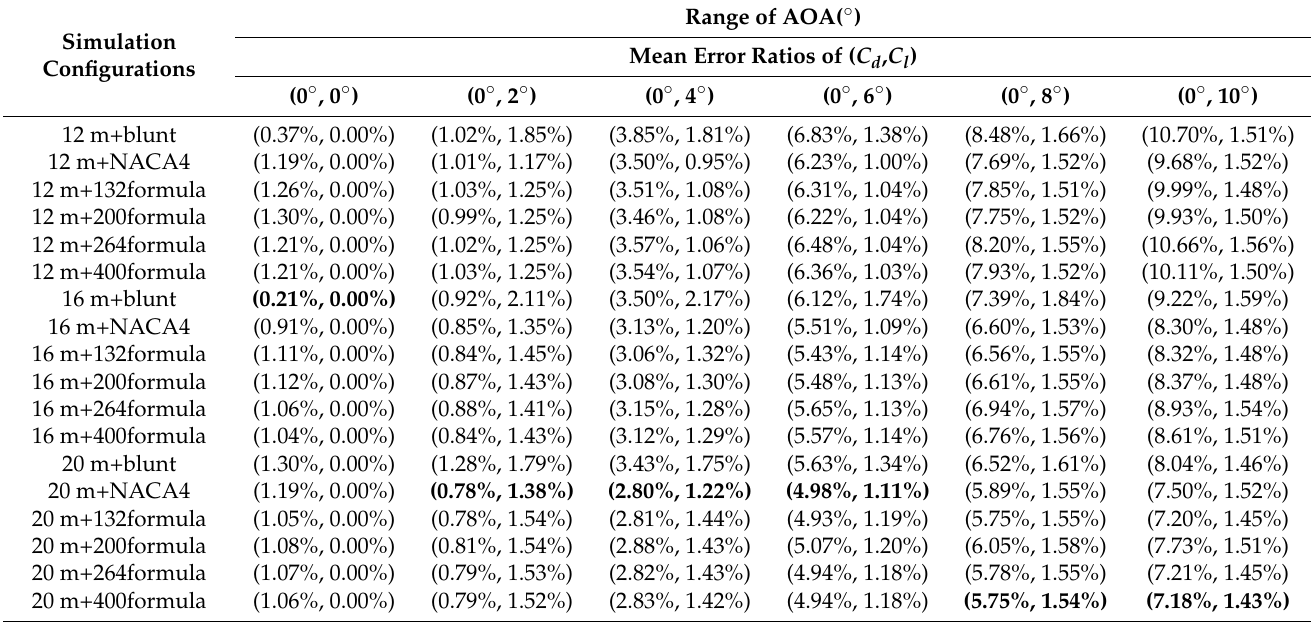
Table 17. The mean error ratios of C d and C l of SST k-omega turbulence model.